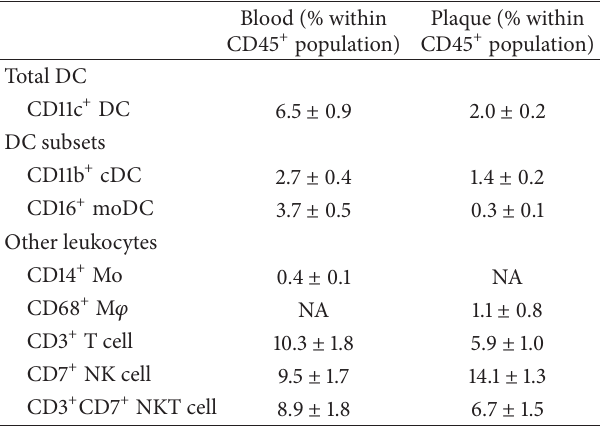
Table 4: Flow cytometric analysis of immune cells in human atherosclerotic plaques and blood. CD45 + population)